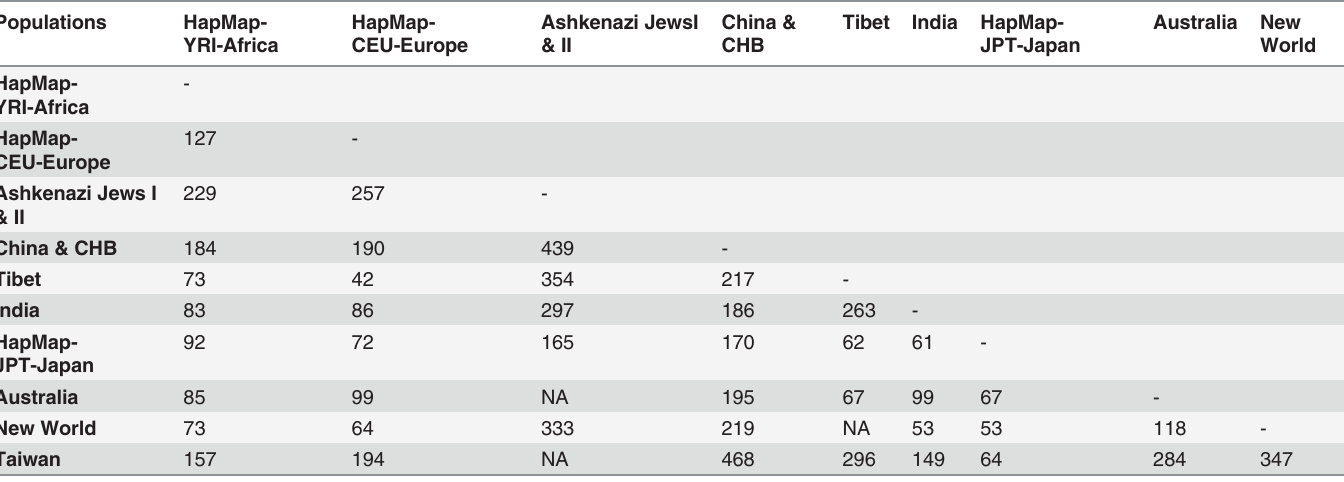
Table 2. Number of shared CNV breakpoints across the study